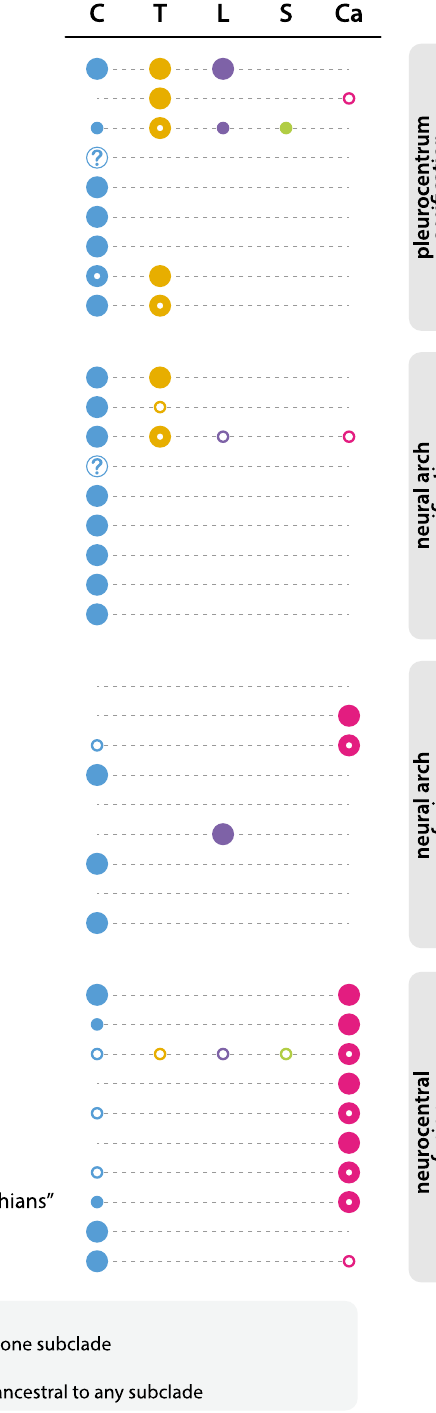
Figure 4. Distribution and ancestral state reconstruction of loci of axial ossification and fusion in amniotes. Colored circles on the grey silhouette represent the reconstructed ancestral condition in amniotes and arrows show the direction of ossification/fusion from each locus. M. tenuidens is excluded from the reconstruction for ( A ) and ( B ), but is included in ( C ) and ( D ). ( A ) Centrum ossification; ( B ) neural arch ossification; ( C ) neural arch fusion; ( D ) neurocentral fusion. Distribution of loci in tip taxa using the same color code. C cervical, T thoracic/anterior dorsal, L lumbar/posterior dorsal, S sacral, Ca caudal. Source data in Figs.